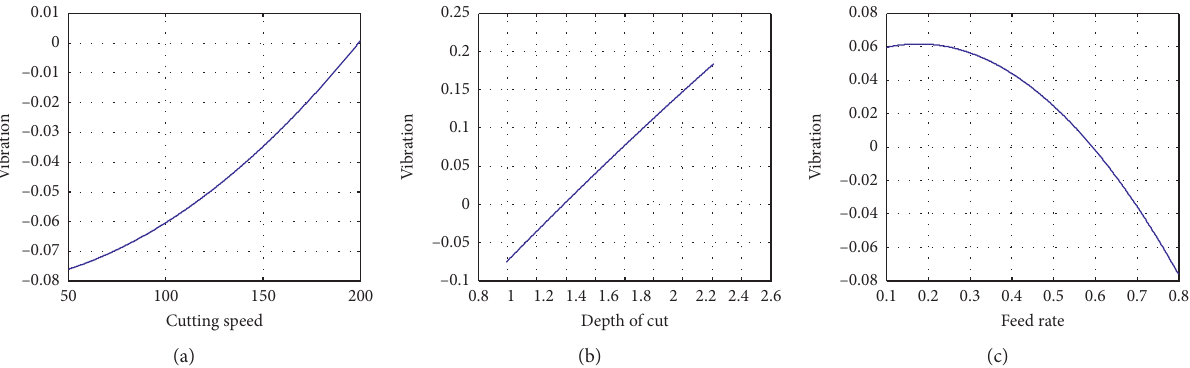
–0.08–0.07–0.06–0.05–0.04–0.03–0.02–0.0100.01 Figure 18: The parameter convergence curves in the vibration optimization. (a) Cutting speed. (b) Depth of cut. (c) Feed Figure 19: The parameter convergence curves in the chip frequency optimization. (a) Cutting speed. (b) Depth of cut. (c) Feed rate.